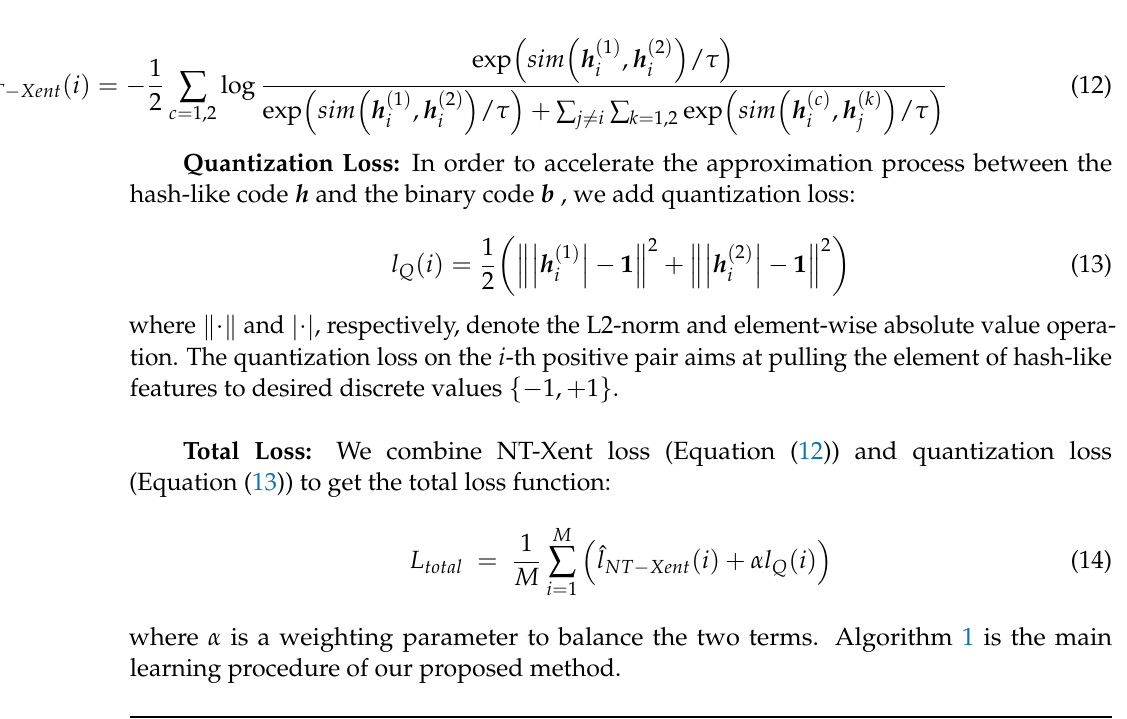
Algorithm 1 DCSH’s main learning